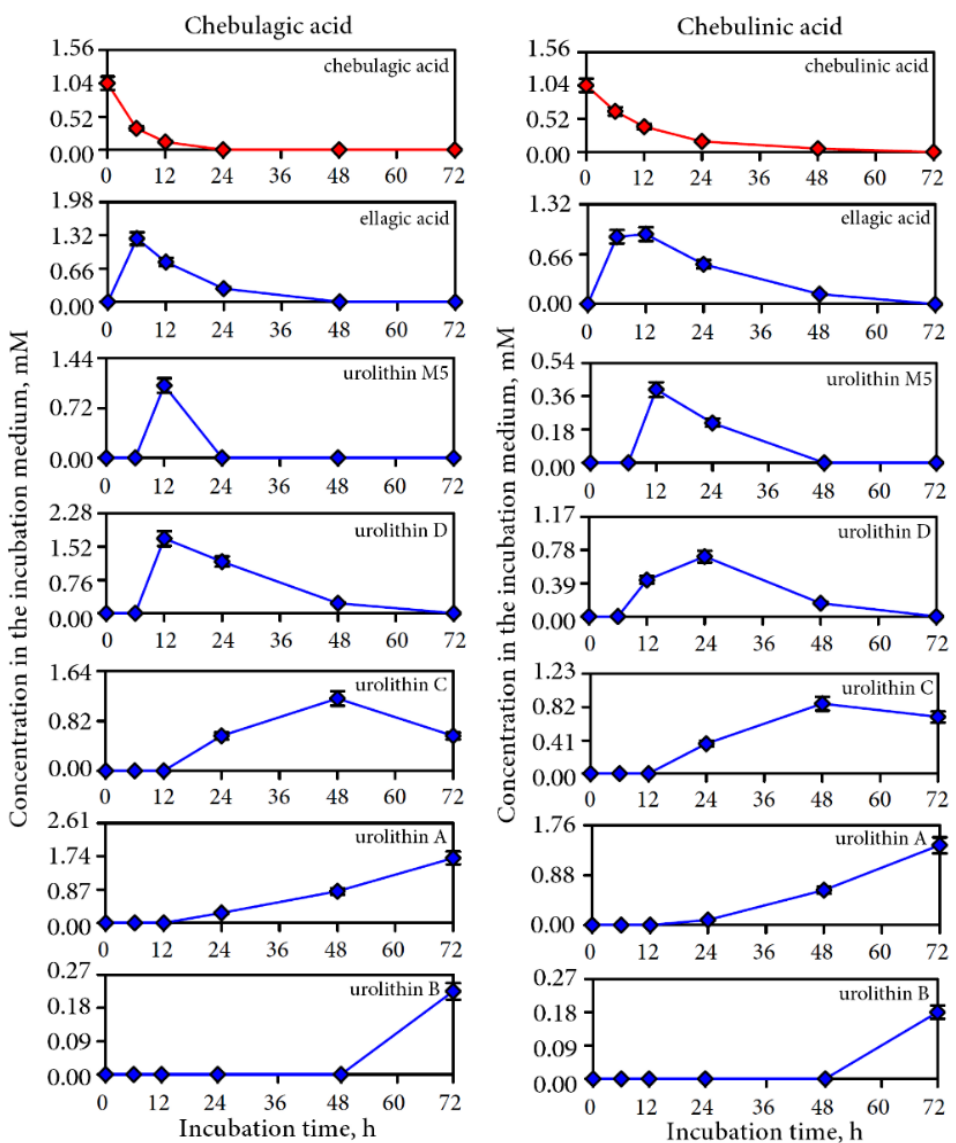
Figure 7. Content of chebulagic acid and chebulinic acid and their microbial metabolites in colonic media after 0–72 h incubation of pure compounds with human gut microbiota.